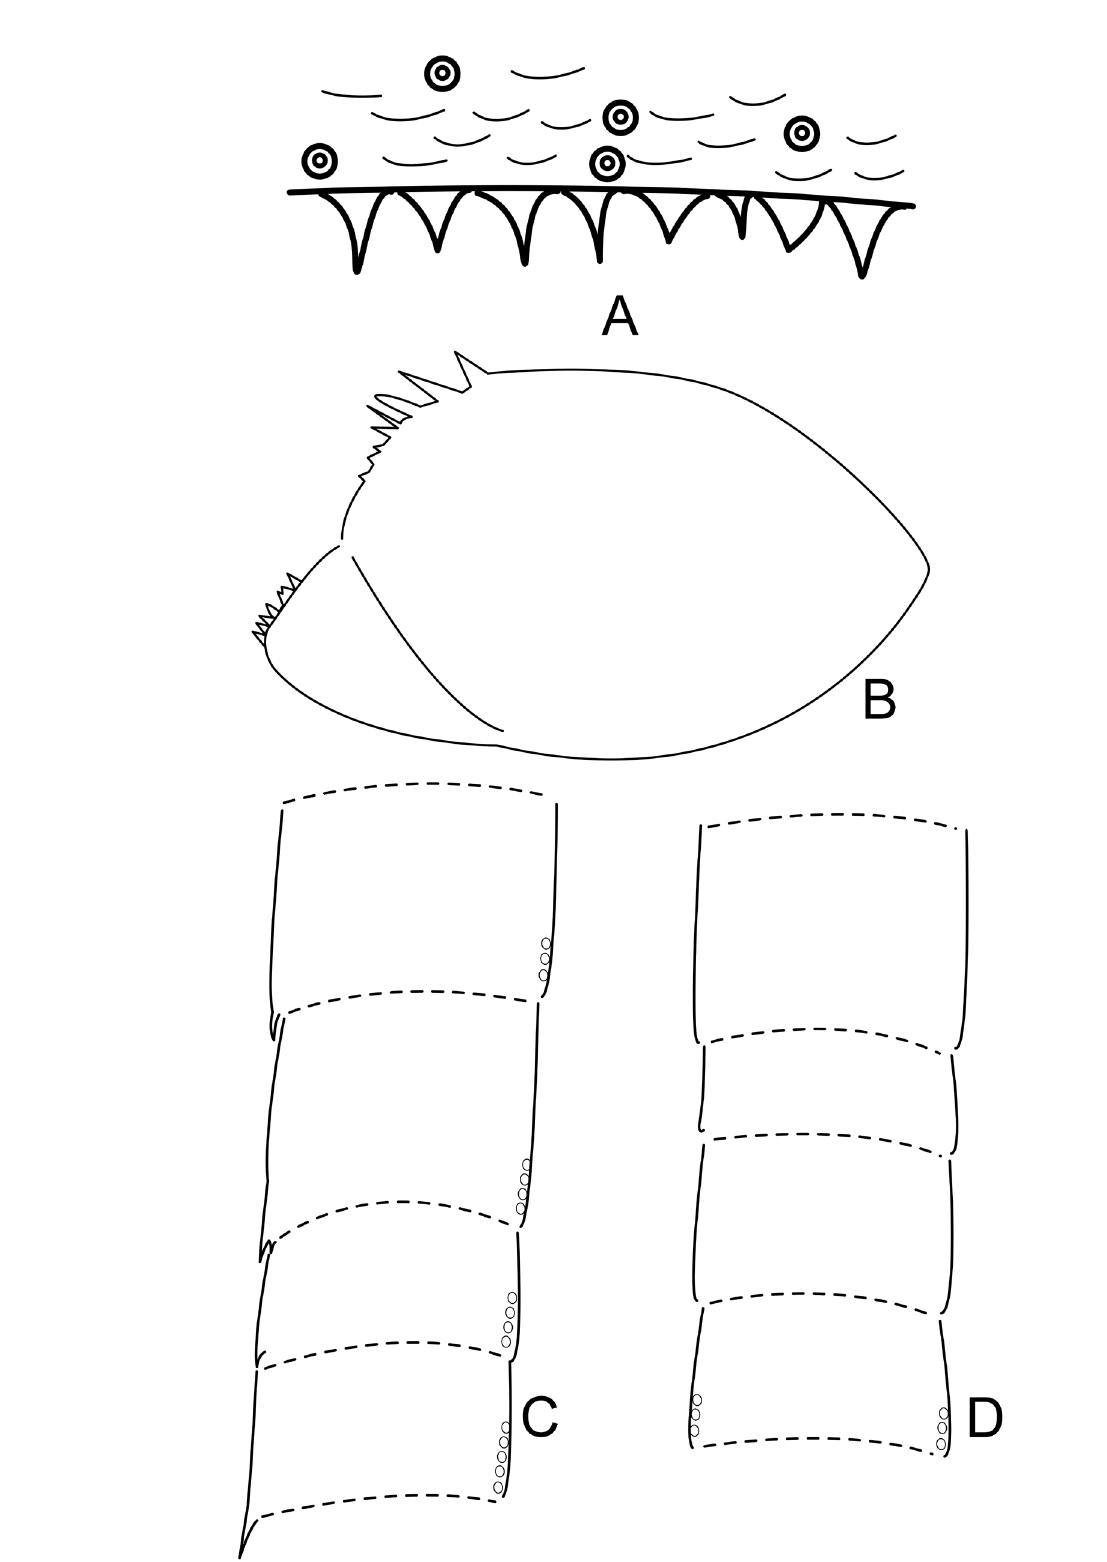
Fig. 14. Rivudiva uiara sp. nov., holotype (INPA). A . Margin of tergum IV. B . Paraproct. C . Cercus. D . Paracercus. Not to